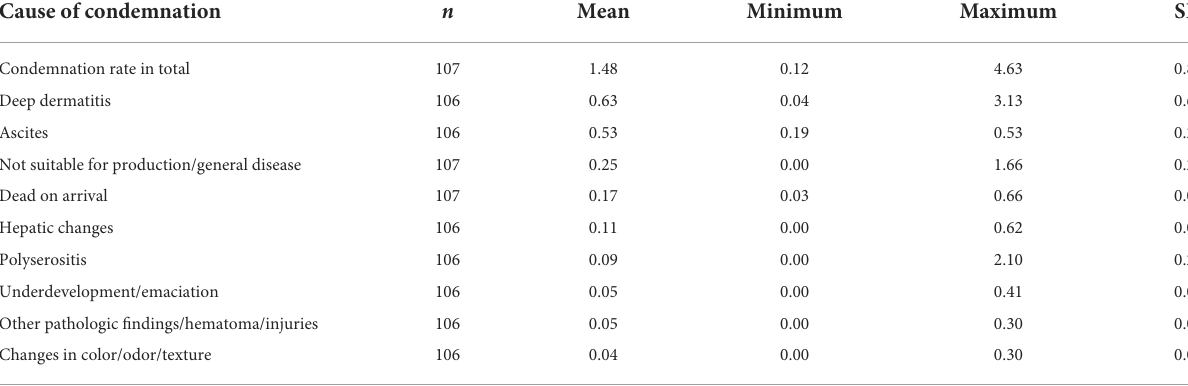
TABLE 3 Causes of condemnation (%), mean, minimum, maximum, and standard deviation